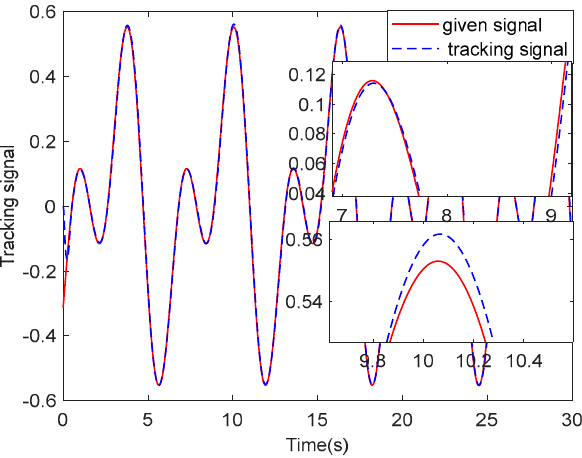
Figure 20. Tracking output of the DRNN-LADRC for the new radar servo system.